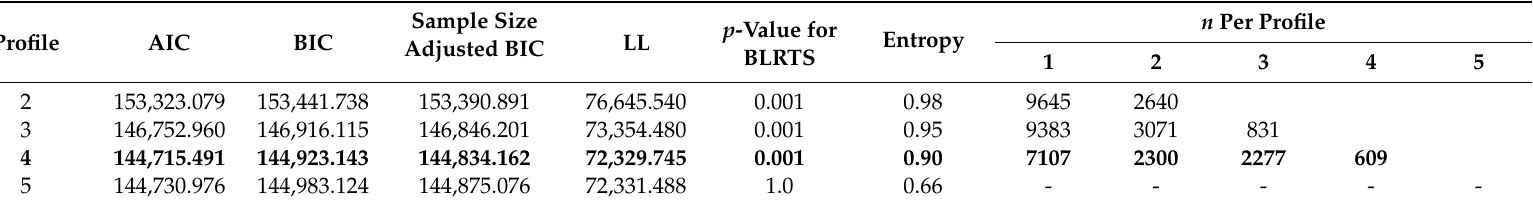
Table 2. Fit of the 2–5 profile models based on the GPIUS2